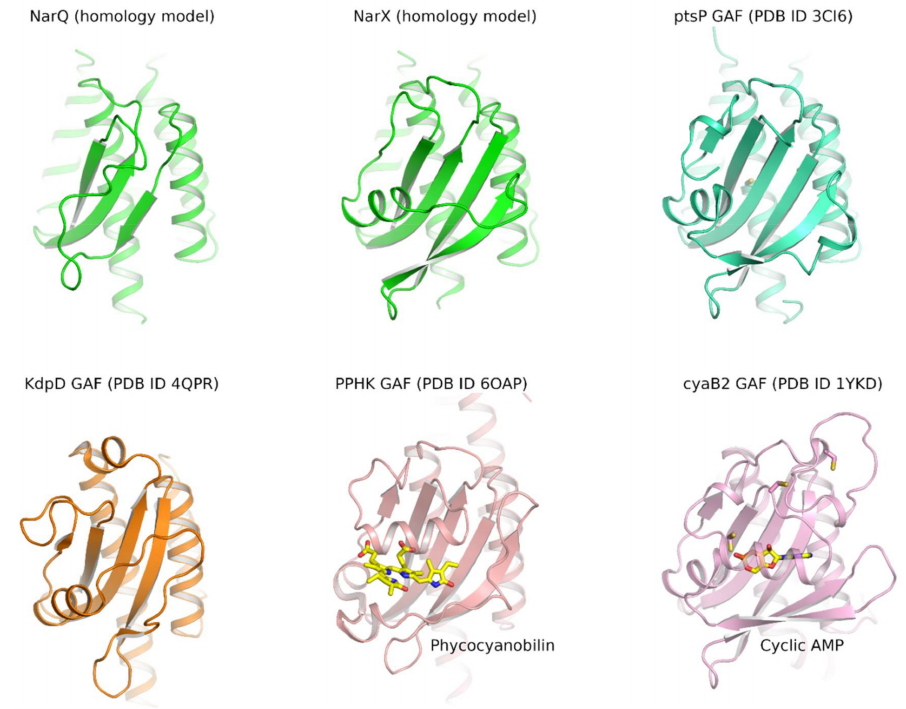
Figure 13. Structural models of different GAF domains: homology models of NarQ and NarX GAF-like domains, which are based on the structure of the Acinetobacter baylyi phosphoenolpyruvate-protein phosphotransferase (ptsP) GAF domain (PDB ID 3CI6); E. coli potassium sensor HK KdpD GAF domain (PDB ID 4QPR [202]); phycocyanobilin-bound Leptolyngbya sp. JSC-1 phosphorylation-responsive photosensitive histidine kinase (PPHK) GAF domain (PDB ID 6OAP, [203]); cyclic AMP-bound Anabaena adenylyl cyclase cyaB2 GAF domain (PDB ID 1YKD [204]). NarQ and NarX GAF-like domains are reduced in size compared to well-characterized GAF